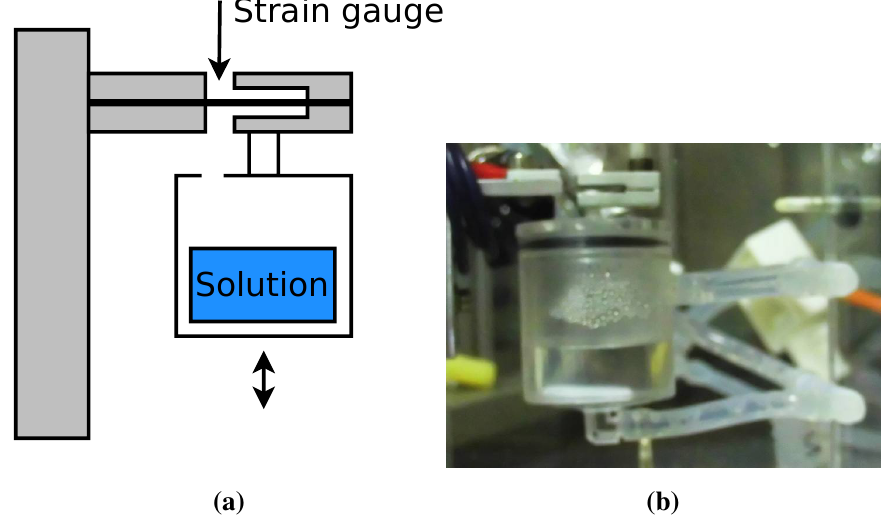
Figure 6. ( a ) The sketch of the weighing mechanism of the tank with the strain gauge; and ( b ) the picture of the actual mixer attached to the strain